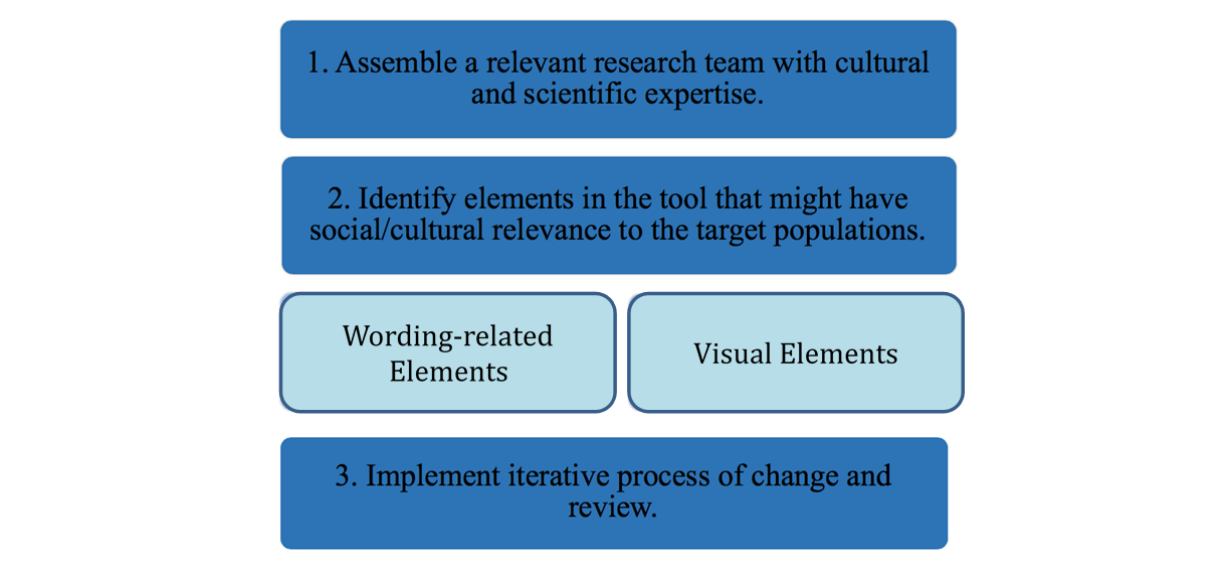
Figure 1. The three-step transcreation